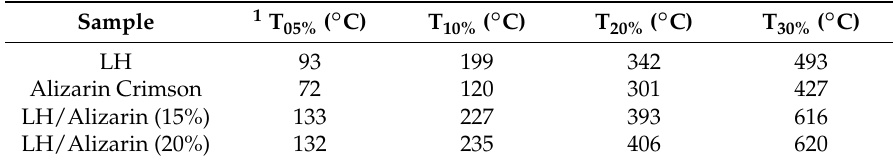
Table 1. Thermogravimetric analysis of LH/Alizarin pigments.